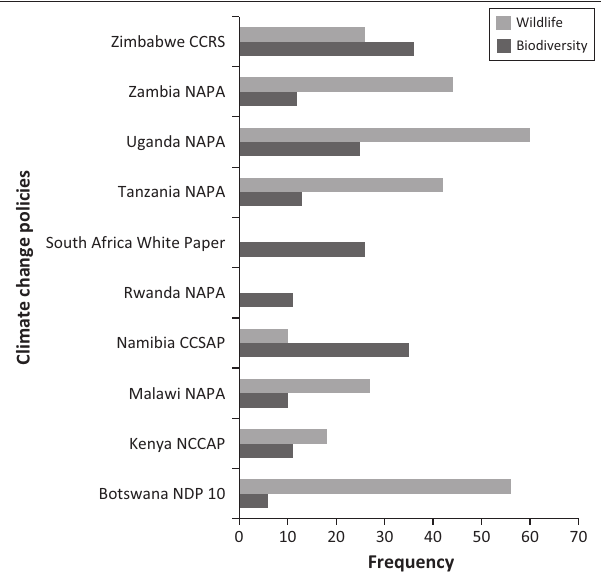
FIGURE 4: Frequency counts for ‘wildlife’ and ‘biodiversity’ in national climate change